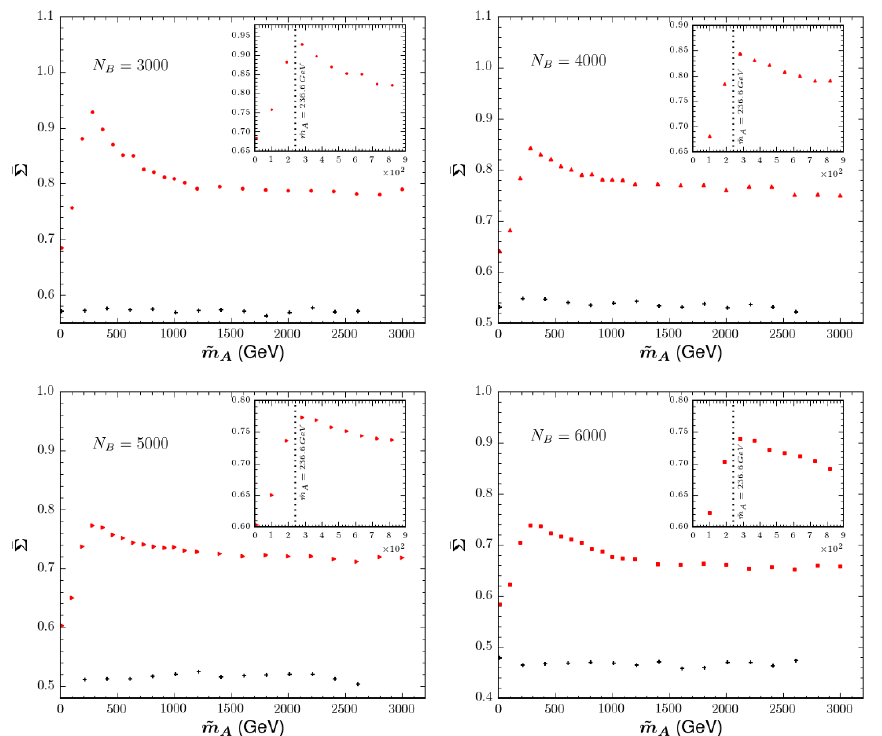
Figure 13 . The analogue of (cid:12)gure 11 for the exercise with t (cid:22) t background events considered in section 3.3. Results are shown for N S = 3000 signal events and several choices for the number of background events: N B = 3000 (upper left panel), N B = 4000 (upper right panel), N B = 5000 (lower left panel) and N B = 6000 (lower right